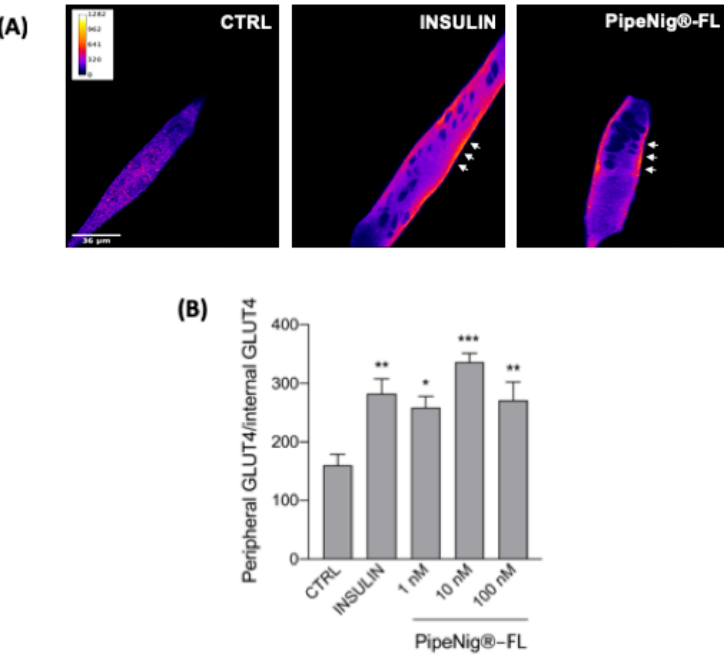
Figure 6. PipeNig ® -FL induces GLUT4 translocation to the plasma membrane. ( A ) Confocal images of a representative experiment of GLUT4 immunofluorescence staining. After PipeNig ® -FL stimulation (1–10–100 nM) the fluorescent signal is clearly localized to the peripheral plasmalemma, thus suggesting the GLUT4 translocation. Images are presented in pseudocolor (LUT = fire) to better show the fluorescence intensity variations. Insulin (25 nM) was used as a positive control. Scale bar 36 µm. ( B ) Bar graph representing the ratio peripheral vs. internal GLUT4 fluorescence intensity. Data are represented as the mean ± SEM of three independent experiments. * p < 0.05; ** p < 0.01; *** p < 0,001 vs. control.